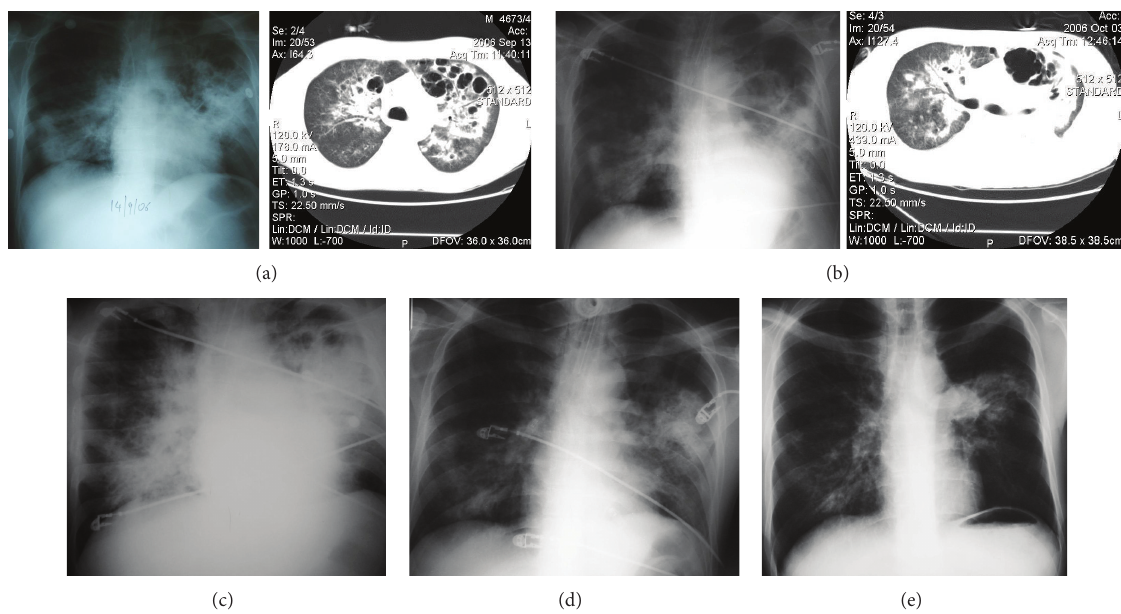
Figure2:(a)5weeksafteradmission,newrespiratoryfailure,bullouslesions,anddenseinfiltrates.(b)7weeksafteradmission,receivingagain